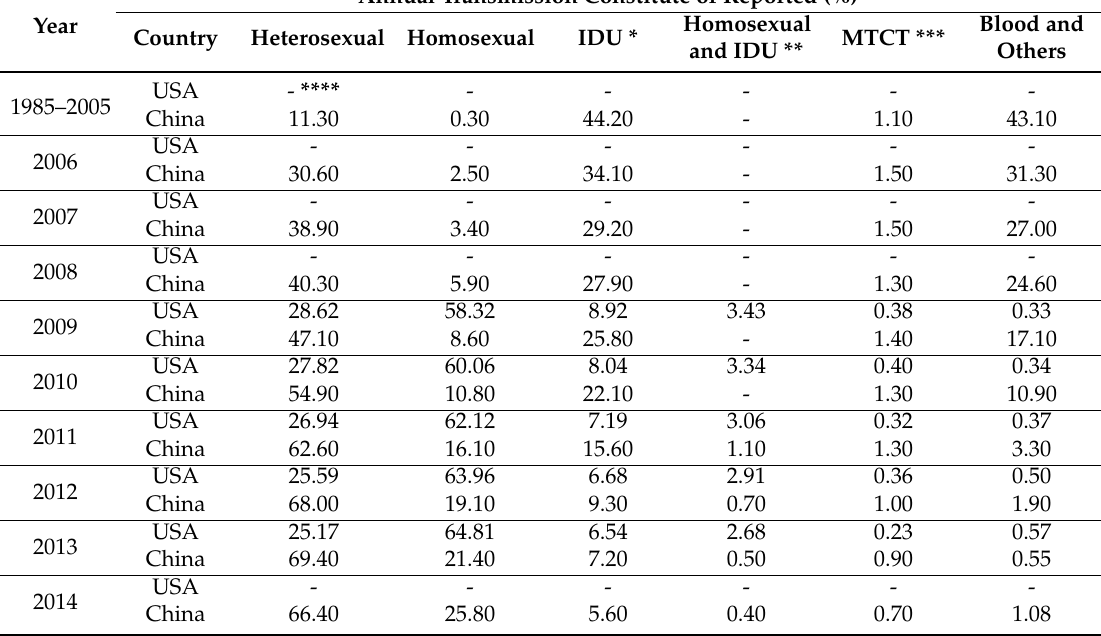
Table 3. Distribution of transmission routes of reported HIV/AIDS cases in the United States and China